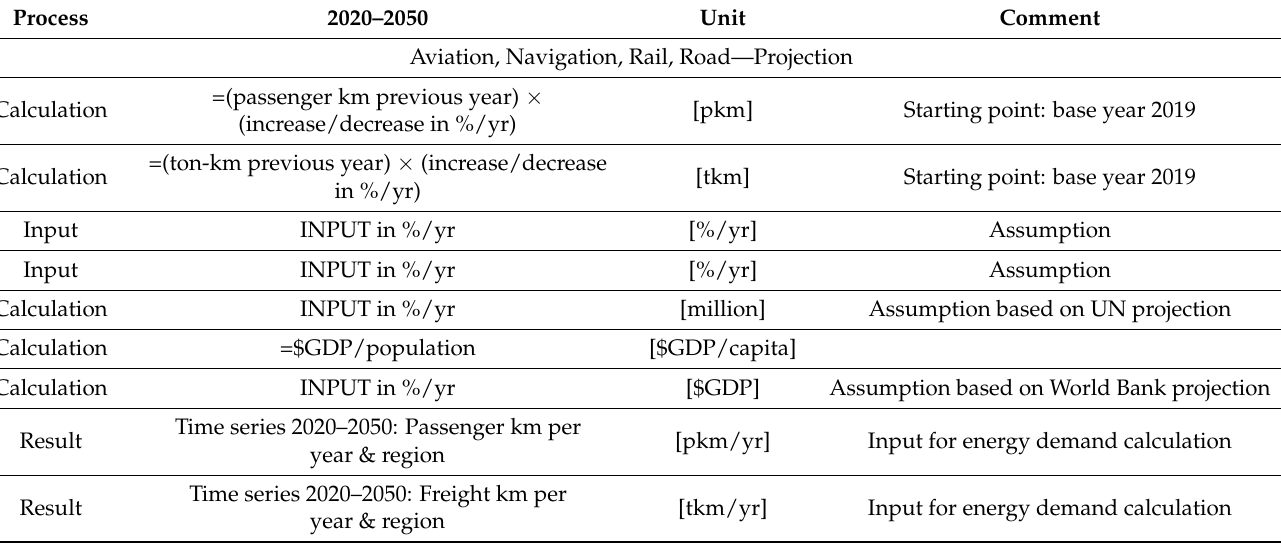
Table 3. Methodology of OECM 2.0—Projection of future transport demand by transport mode.